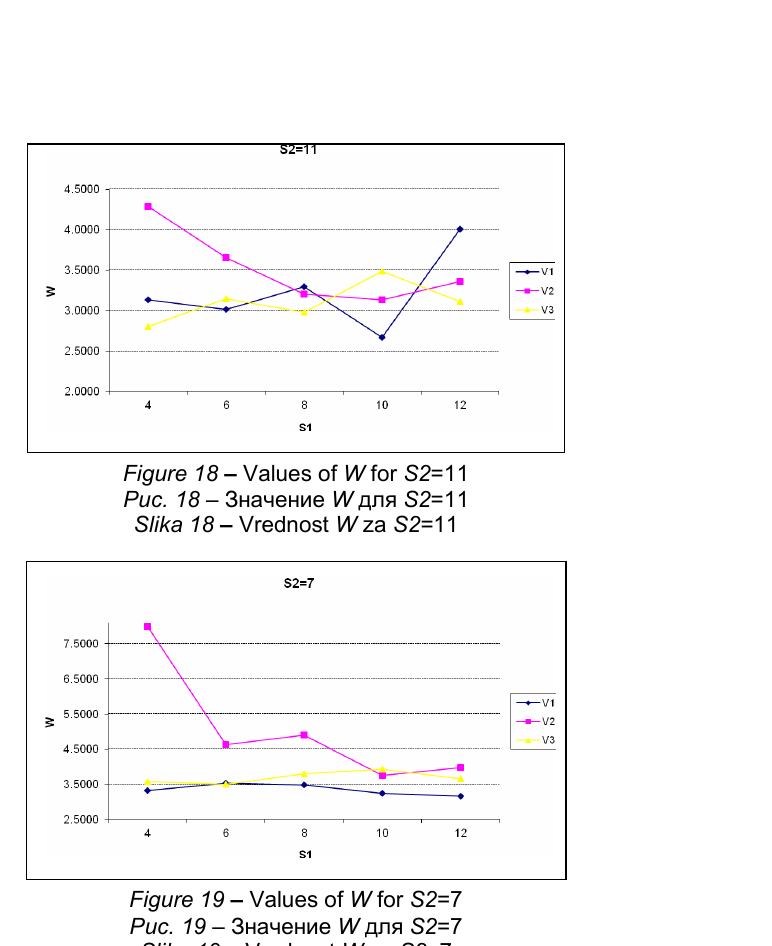
Figure 19 – Values of W for S2 =7 Рис . 19 – Значение W для S2 =7 Slika 19 – Vrednost W za S2